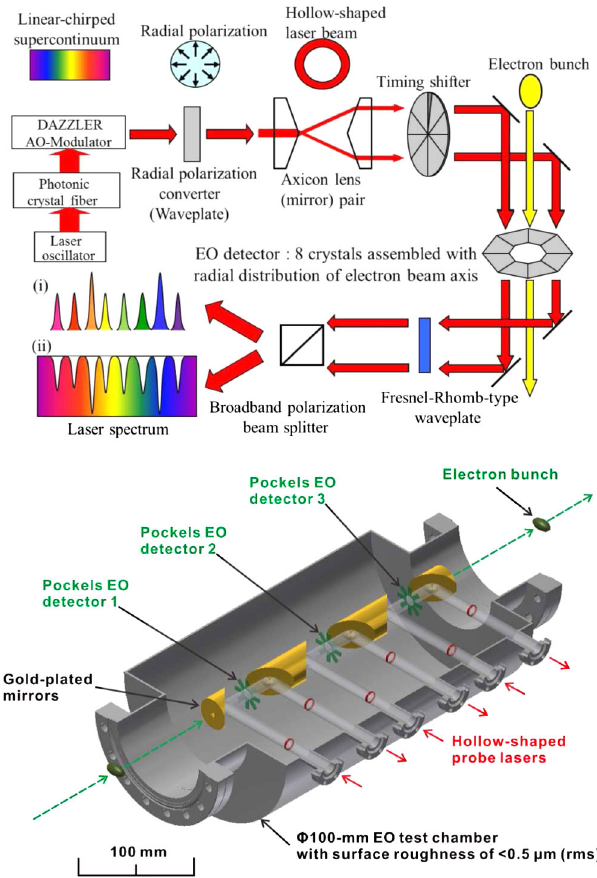
FIG. 1. Schematic of elements of 3D-BCD monitor (upper) and total system of 3D-BCD